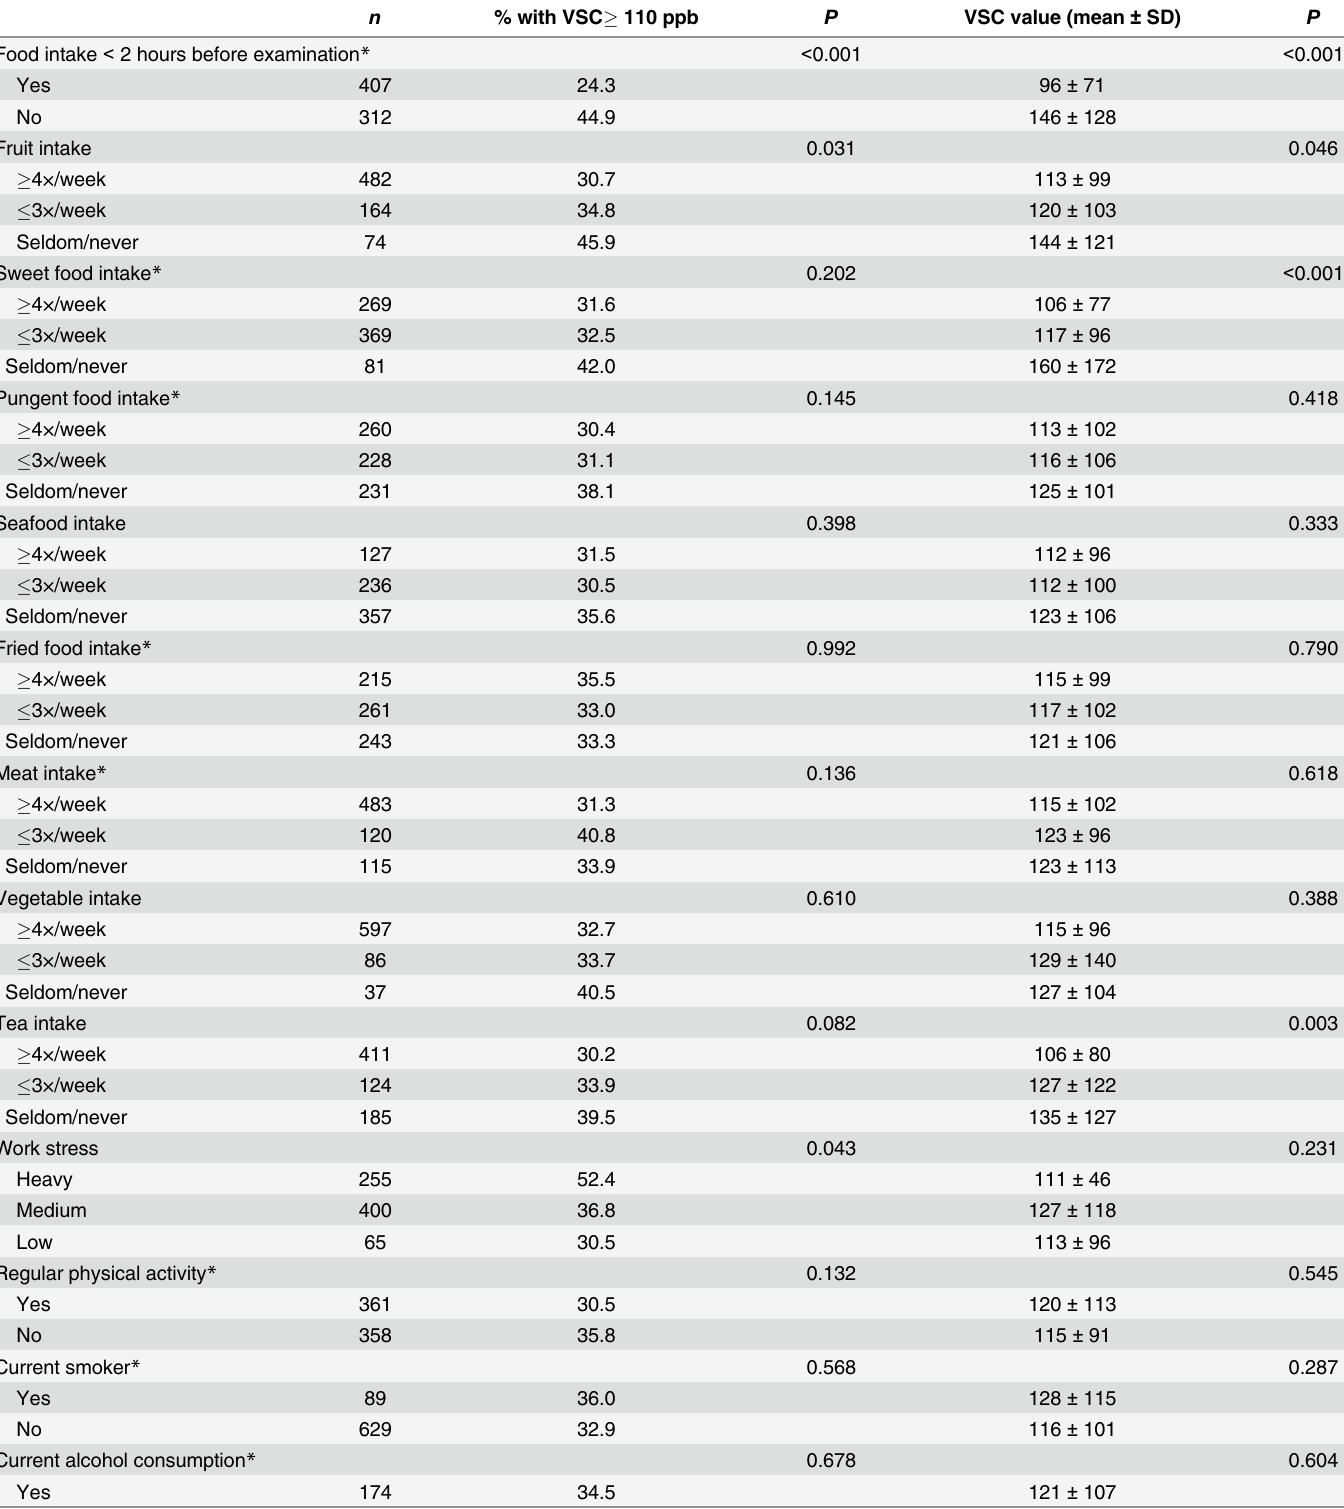
Table 4. Relationships between oral malodor measurements and health behaviors # . n % with VSC (cid:1) 110